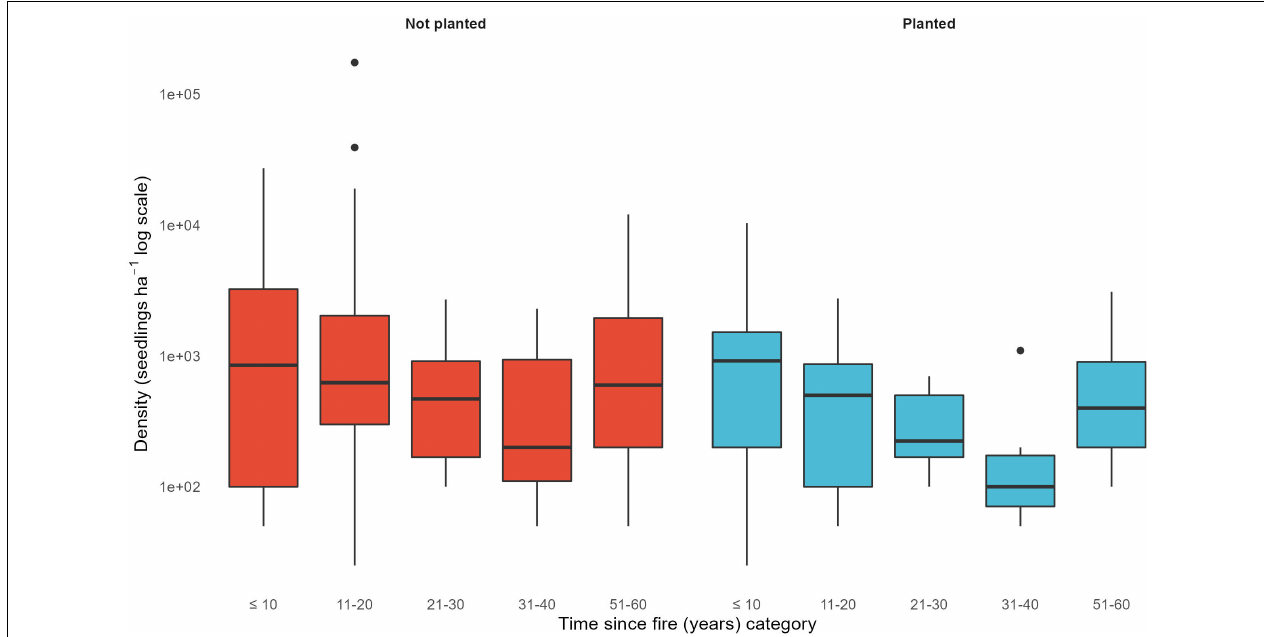
FIGURE 5 | Regeneration density (seedlings · ha − 1 on a log scale) in not-planted (red) and planted (blue) stands over time since fire. Data are averaged across stands within planting treatments in 10-year time since fire bins (no stands in 40–50 years